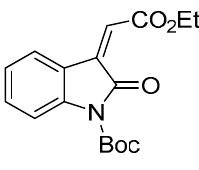
Figure 1. An oxindole derivative used as a Michael acceptor in a VMA/Aldol reaction cascade.